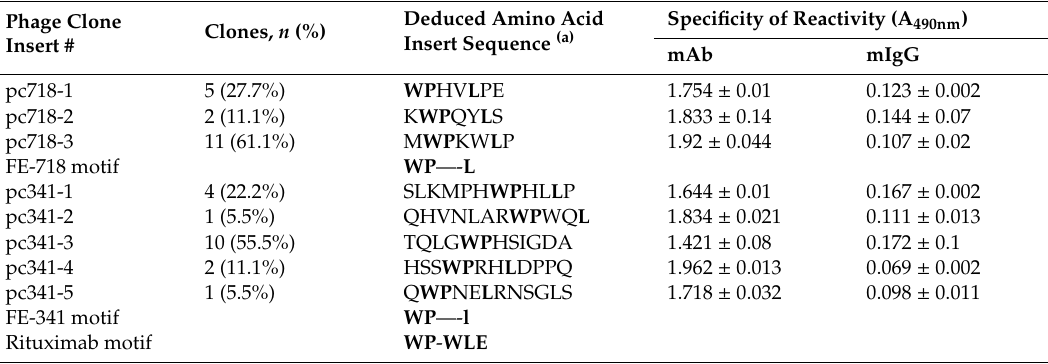
Figure 3. ( A ) Competitive binding assay to define the relative avidity of mAb FE-718 and FE-341 for Rp5-L. Ten-fold serial dilution of mAb FE-718 and FE-341 were mixed with an equal volume of an appropriate dilution of Rituximab and added to wells previously coated with Rp5-L. Following a 2-hour incubation at R / T, Rituximab-bound was detected with HRP-conjugated goat anti-human Ig (Fc portion). The anti-HLA class I mAb HC-10 was used as control. Results are expressed as percentage inhibition of binding compared with binding in the absence of inhibitor. The data are representative of two experiments. The O.D. of uninhibited Rituximab was 2.41 ± 0.23 S.D. ( B ) Reactivity of mAb FE-718 and FE-341 with CD20 + B lymphoid cells. mAb FE-718 and FE-341 were added to rabbit IgG-treated CD20 + B lymphoid Raji cells. Bound antibodies were detected with an appropriate dilution of FITC-conjugated goat anti-mouse IgG. Rituximab was used as control. Table 2. Definition of mAb FE-341- and FE-718-specific